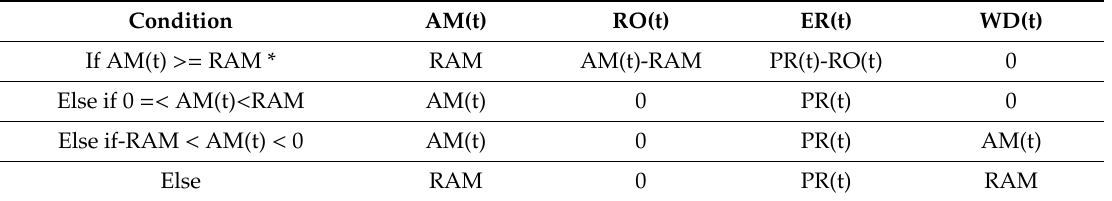
Table 2. Calculation of available soil moisture (AM(t)).